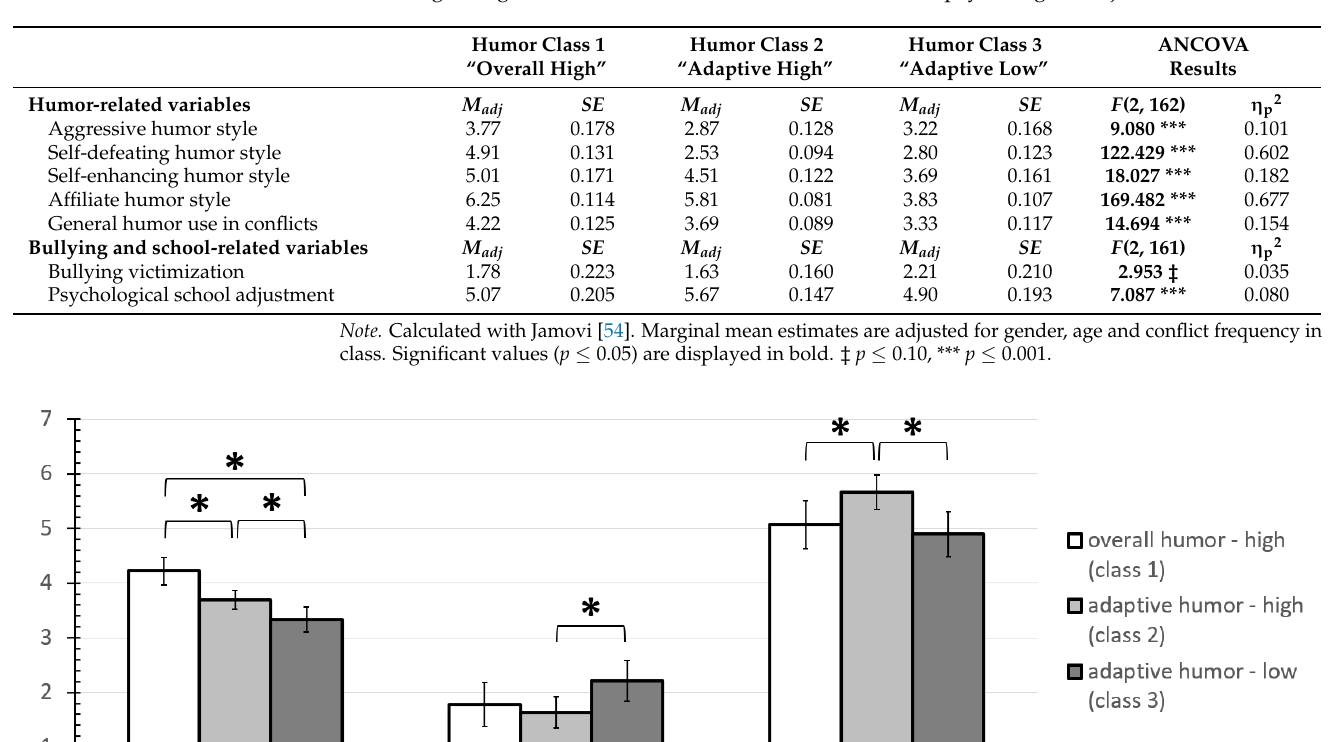
Table 5. ANCOVA results: Marginal means and standard errors in humor style-related latent profile classes regarding humor-related variables, victimization and psychological adjustment in school.